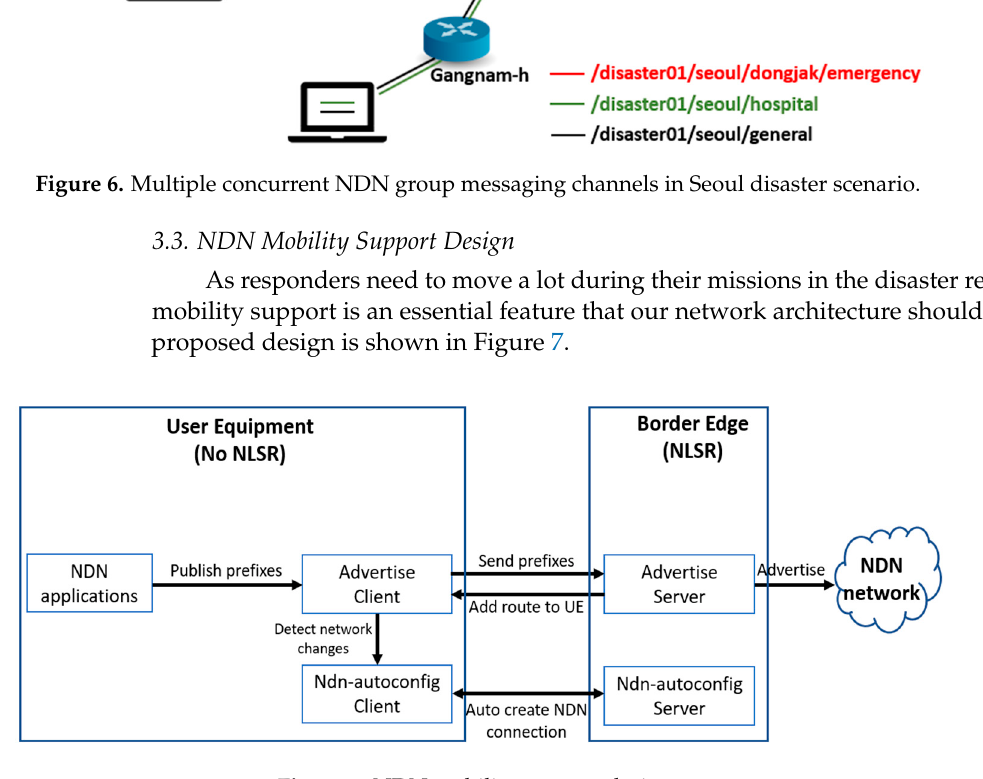
Figure 7. NDN mobility support design.